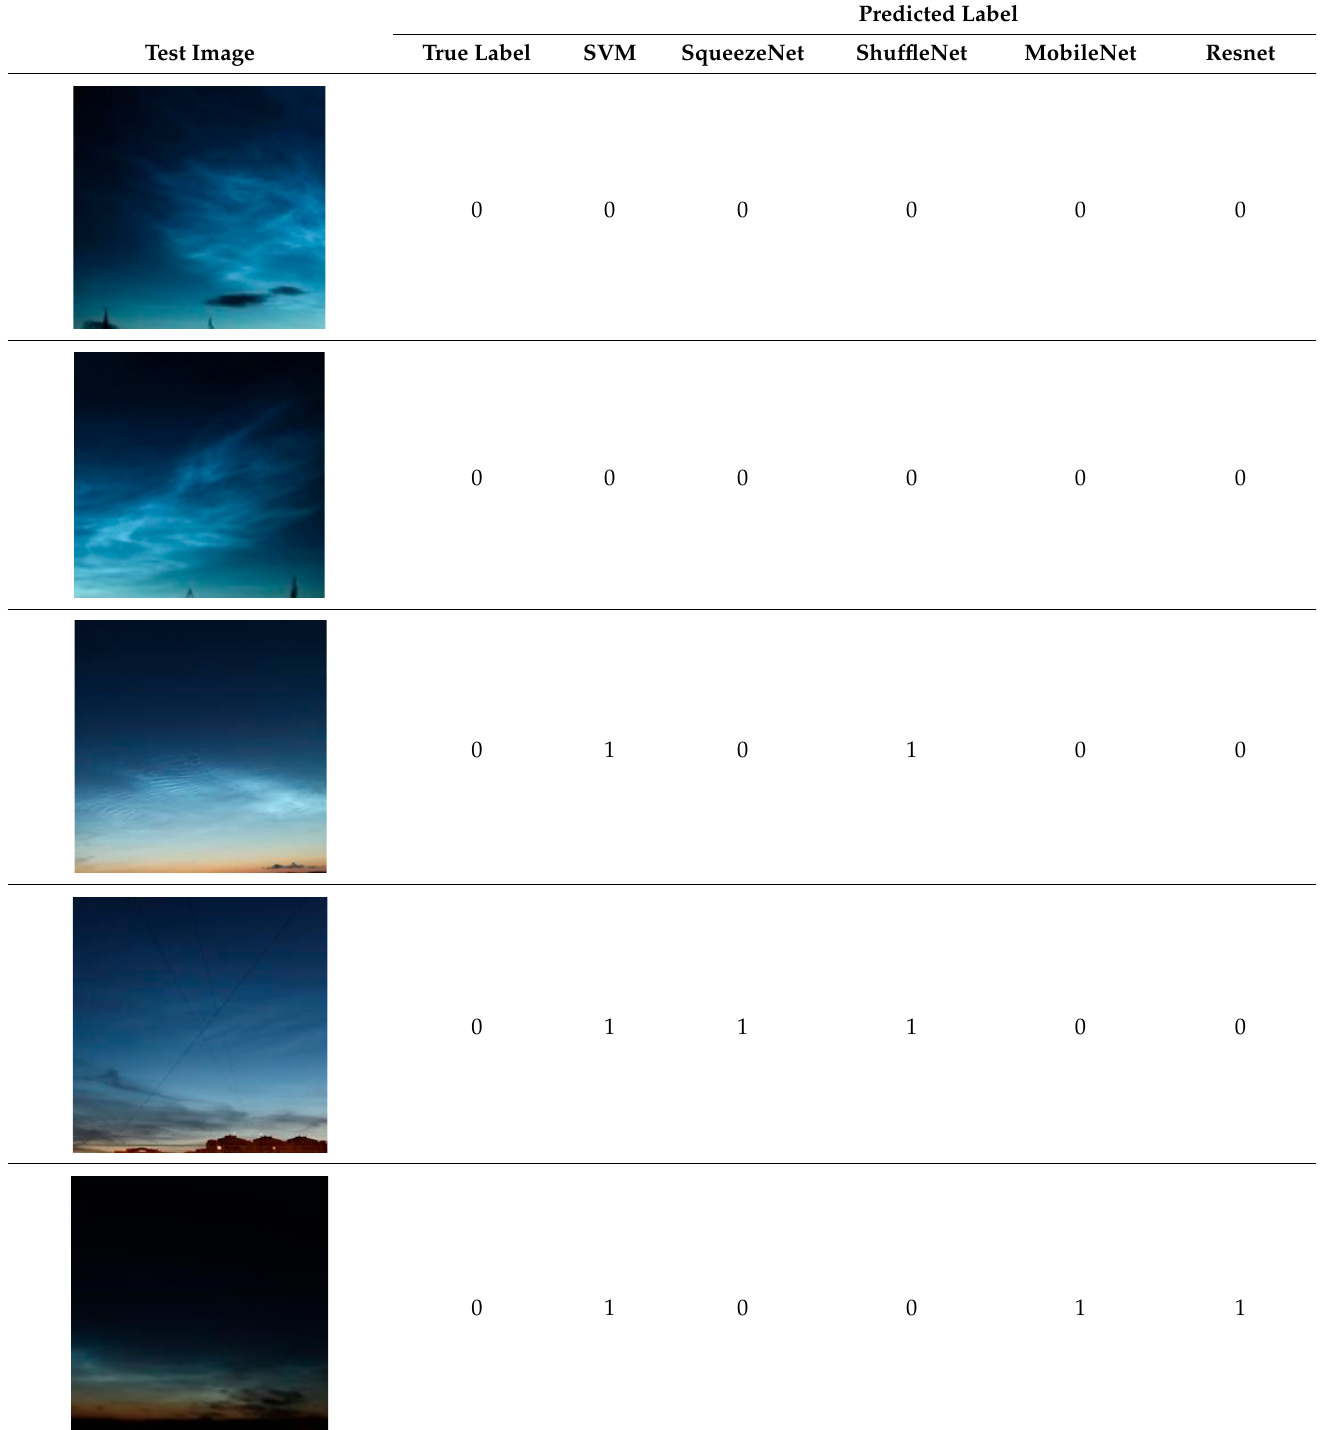
Table 2. Test images with true labels and their predictions: label 0 represents NLC and label 1 represents other category.